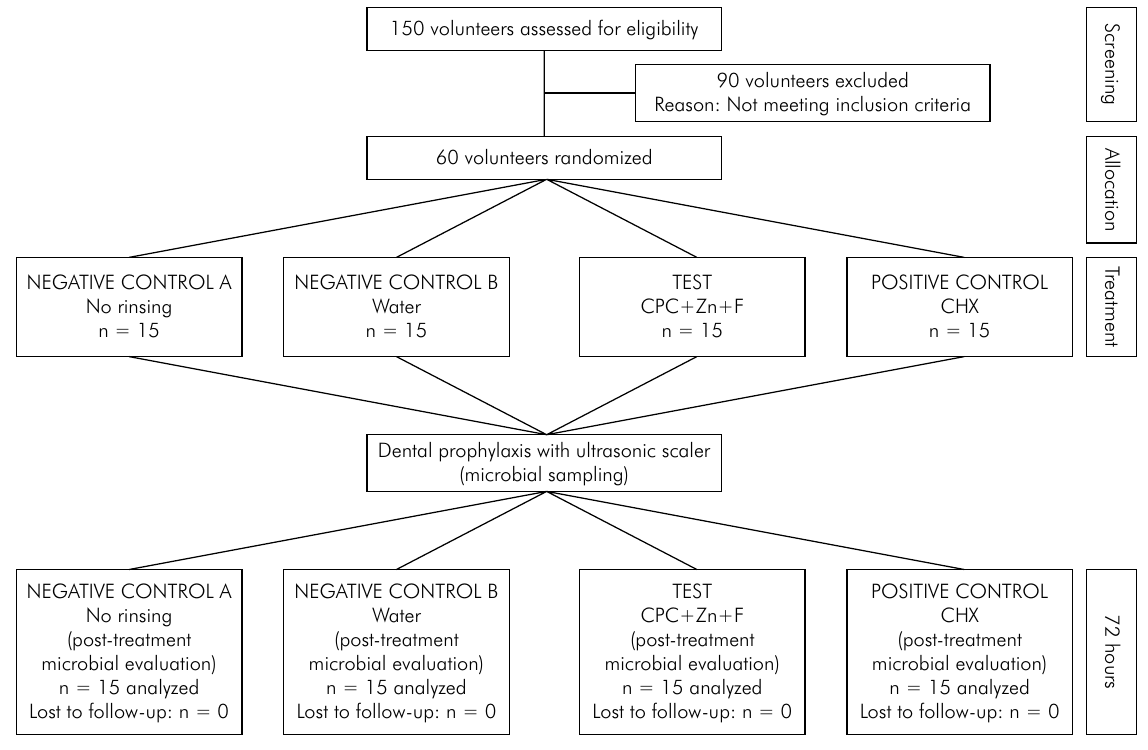
Figure 2. Flow chart of the study